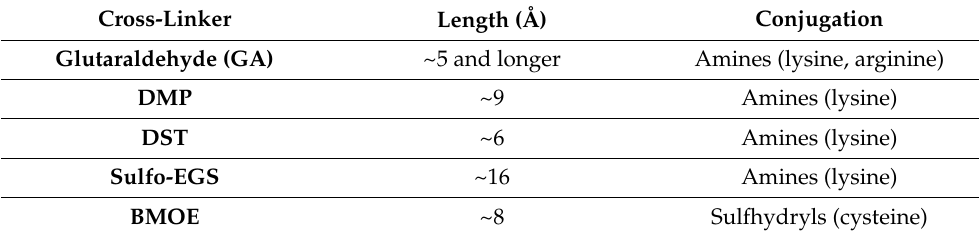
Table 1. Length and conjugation of the used linkers.